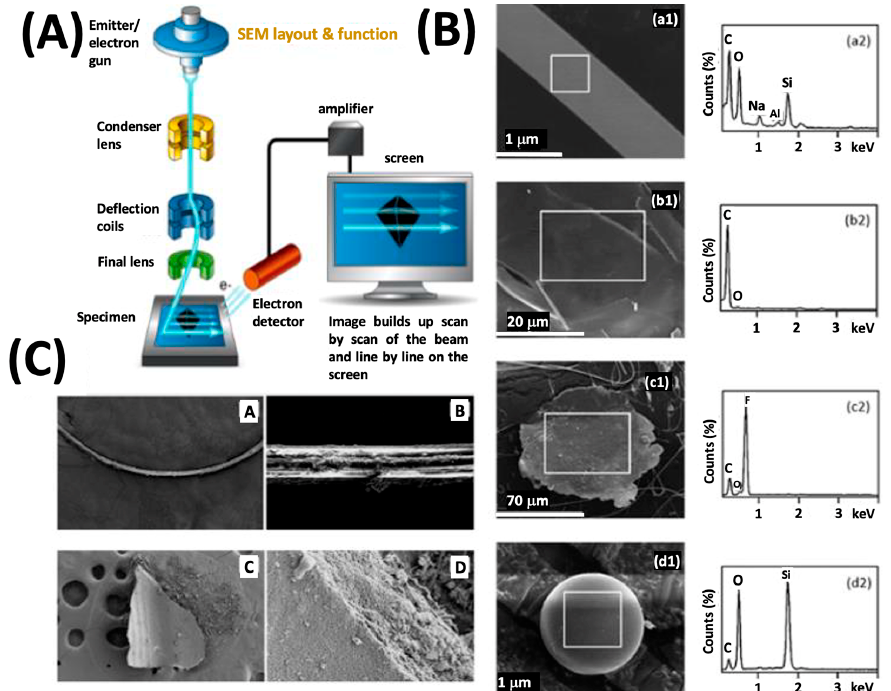
Figure 3. ( A ) Schematic of an SEM instrument [54]. ( B ) SEM images ( a1 – d1 ) and EDX spectra ( a2 – d2 ) from suspect microplastic particles isolated from marine organisms. SEM with EDX allows investigators the ability to exclude particles from being microplastics, as is case of object ( d1 ), which appears to be silica [51]. ( C ) SEM images from microplastic ( A – D ); SEM images of microplastic debris extracted from the stomach contents of Bursatella leachii specimens [55]. Figures have been reproduced with permission of